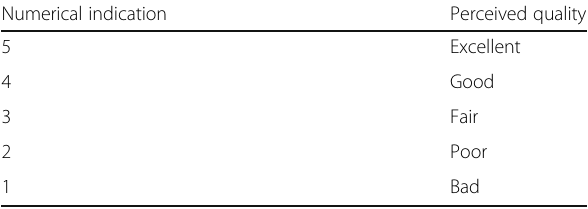
Table 1 Speech quality characterized by MOS-LQO scores Numerical indication Perceived